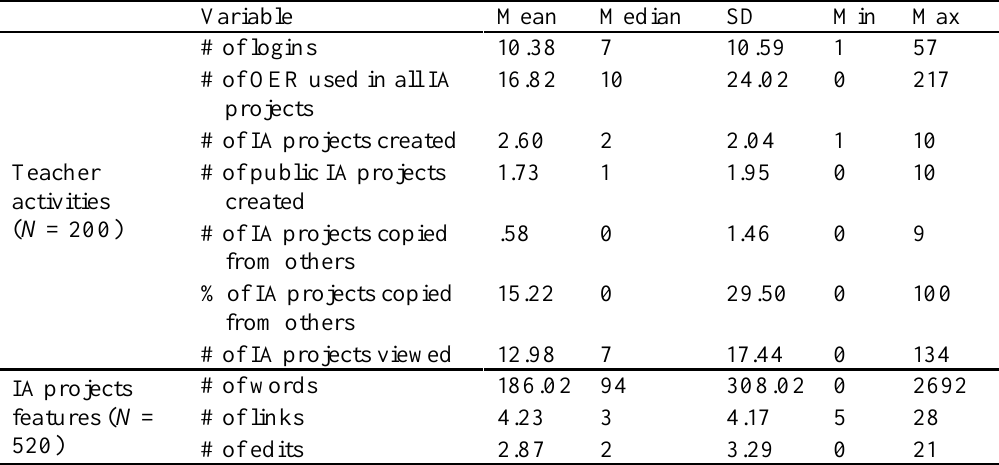
Descriptives of Users’ (N = 200) Activity and Their IA Project Features (Data Collected over a 1-Year